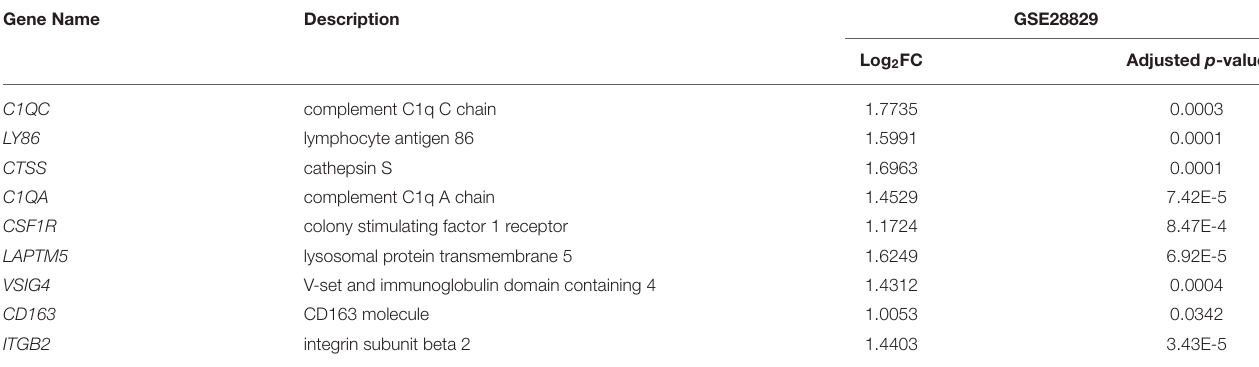
TABLE 1 | Detailed information of the cluster genes.